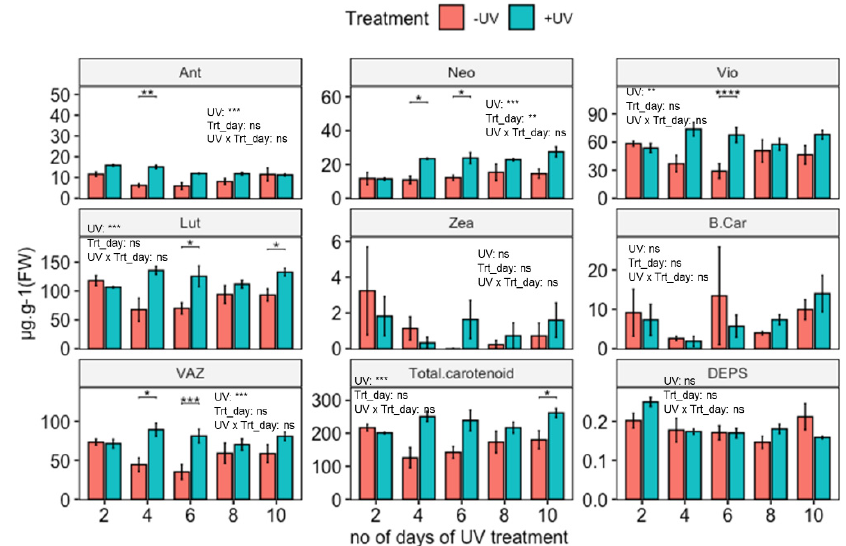
Figure 2. Carotenoid contents ( µ g · g − 1 FW, except DEPS) of wild-type Arabidopsis thaliana (Col-0) exposed to varying durations of UV. Plants were subjected to UV treatment for 3.75 h daily and harvested after 18 h on days 2, 4, 6, 8 and 10. Bar plots show means and error bars indicate standard error for n = 5. The text in each panel shows the outcome of a two-way ANOVA across treatment and exposure duration. The stars above pairs of bars show the outcome of t -tests between the UV treatments. In both cases * ( p < 0.05), ** ( p < 0.01), *** ( p < 0.001), **** ( p < 0.0001), depict significant